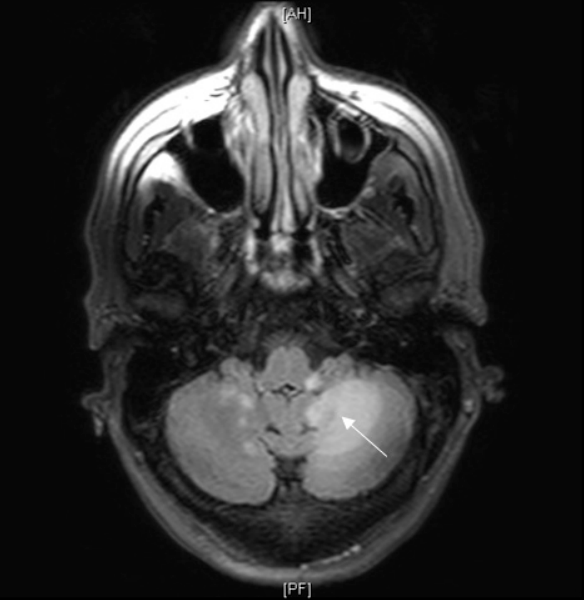
Figure 4. Brain magnetic resonance imaging from our patient with progressive multifocal leu- koencephalopathy. Hyperintense left cerebellar mass on T2 FLAIR weighted sequences (arrow). Treatment with mirtazapine and cidofovir was introduced with good tolerance and allowed a partial regression of the neurological disorders with a favorable evolution after.